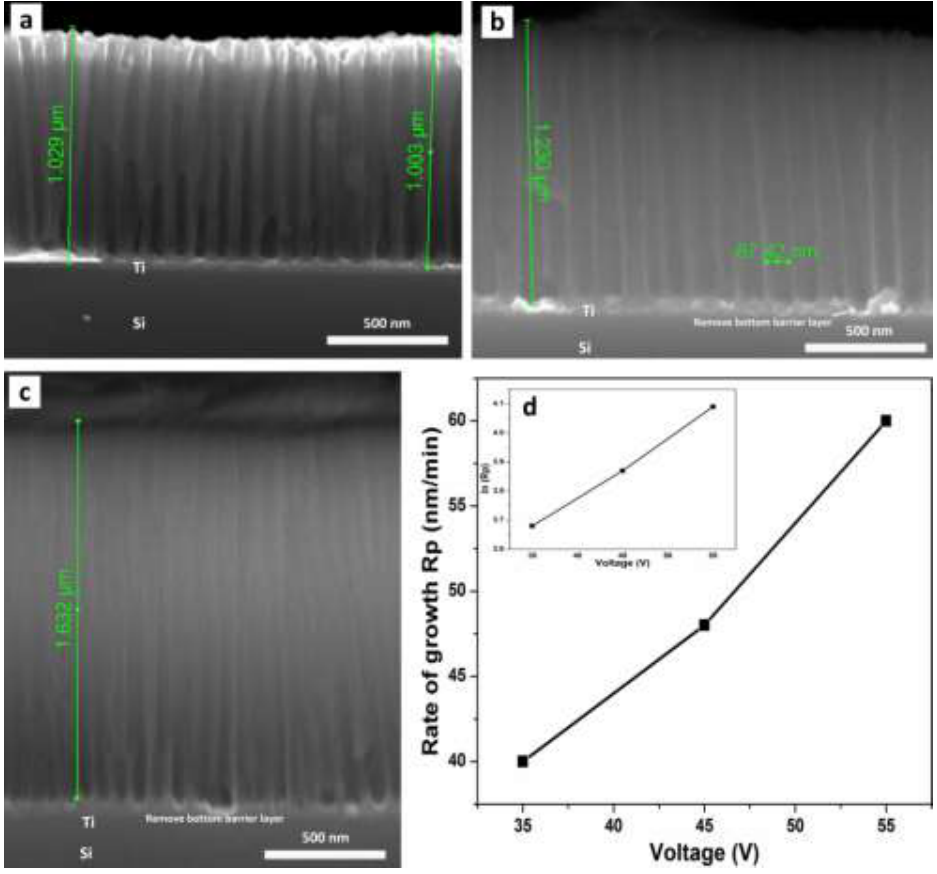
Figure 3: (a), (b) and (c) show FESEM images cross-section of the AAO patterns were prepared under anodizing voltage 35, 45, 55 V, respectively. (d) Depicts the growth rate curve as a function of anodizing. The semi- logarithmic plot of growth rate as a function of anodizing voltage is shown in the upper inset.